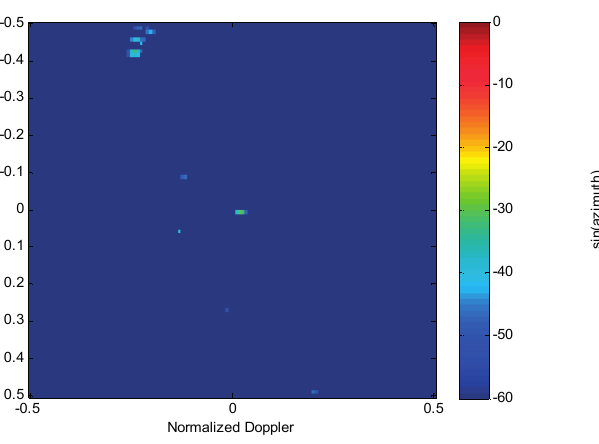
Figure 6. Outputs of Knowledge-aided image feature based detection algorithm. ( a ) Results of the first detection stage. ( b ) Results of the second detection